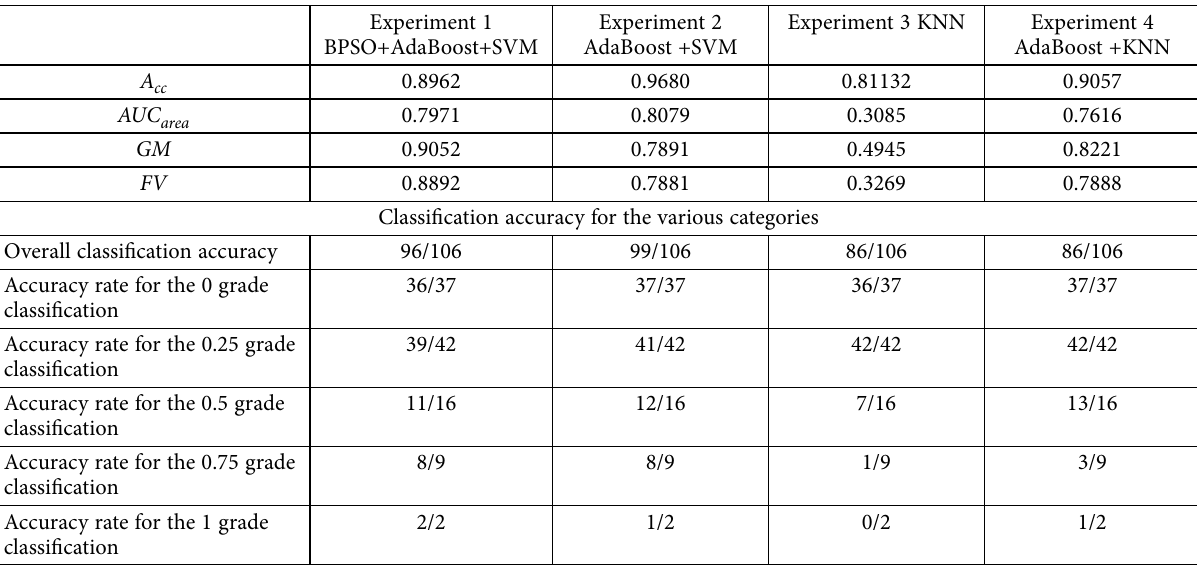
Table 13. Analysis of the results for the classification